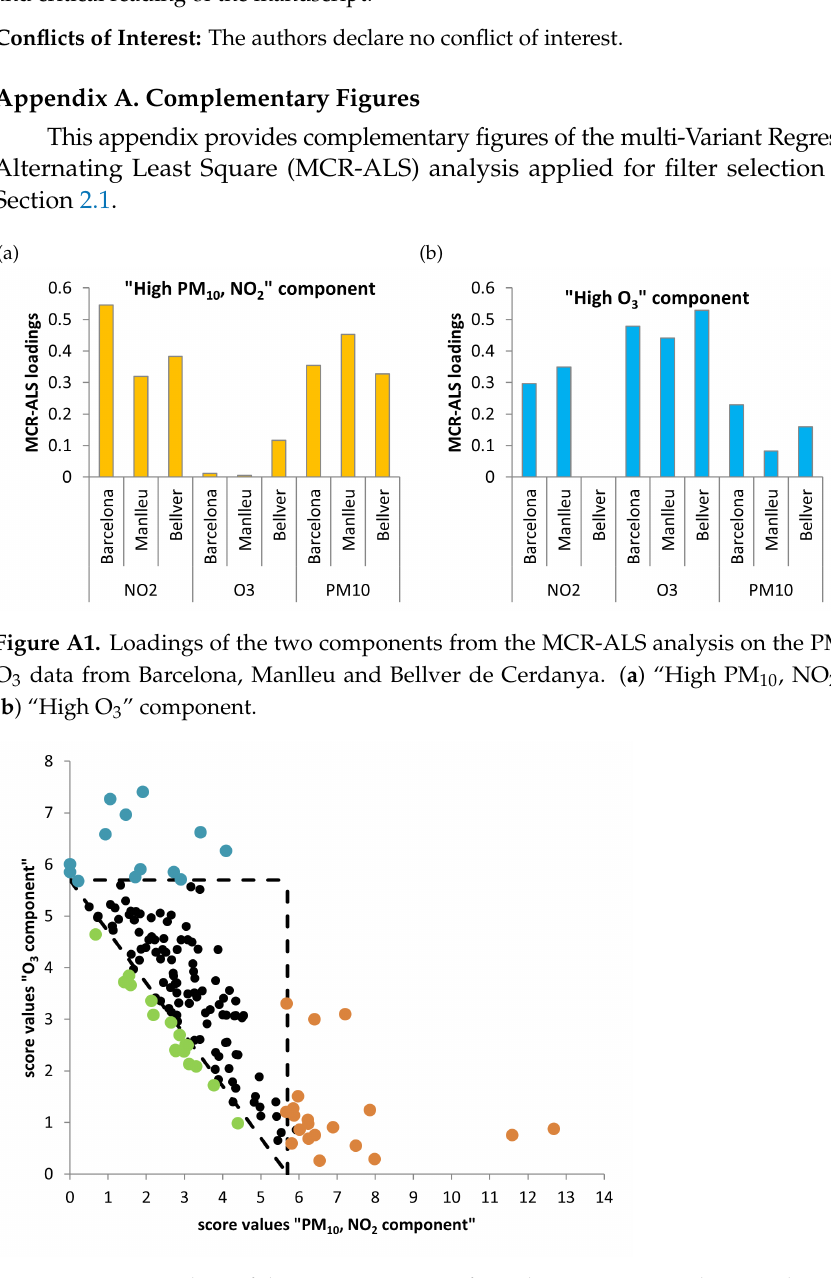
Figure A2. Score values of the two components from the MCR-ALS analysis on the PM 10 , NO 2 , and O 3 data from Barcelona, Manlleu and Bellver de Cerdanya between august and December 2019. The 5.6 cut-off value is indicated for the selection of days, for: (1) high PM 10 and NO 2 concentrations in the tree stations (Orange), (2) high O 3 concentrations in all three stations (Blue), and (3) low PM 10 in all three stations